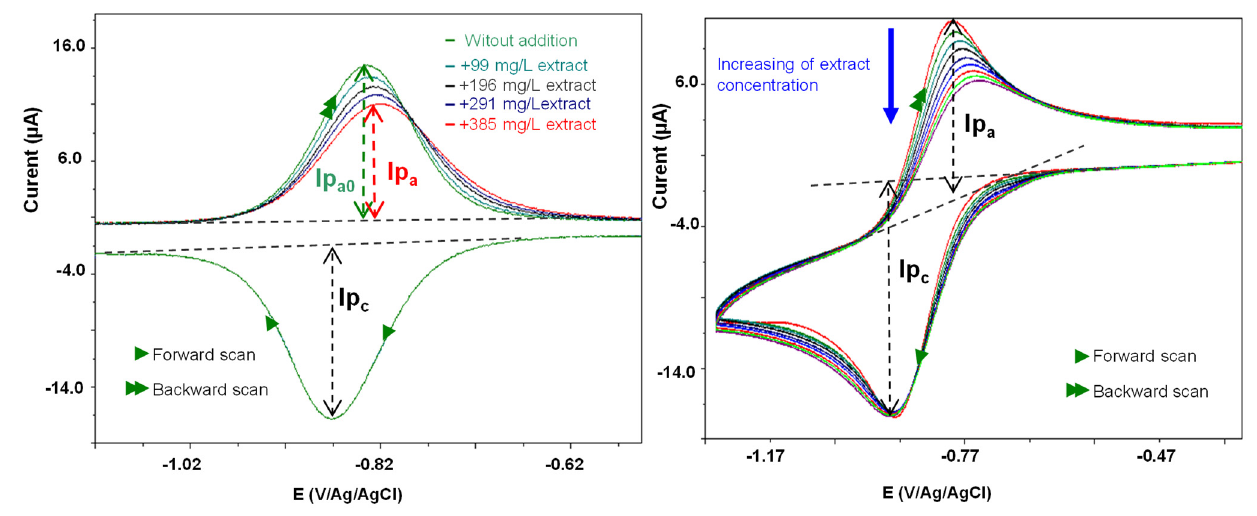
Figure 4. Cyclic voltammograms of O 2 •− in the absence and the presence of increasing concentrations of Nigella damascena L. extract at a steady glassy carbon disk electrode in DMF/0.1 M Bu 4 NPF 6 ; scan rate 0.1 V s − 1 . ( A ) Time semi-derivative convoluted curves; ( B ) CV curves.